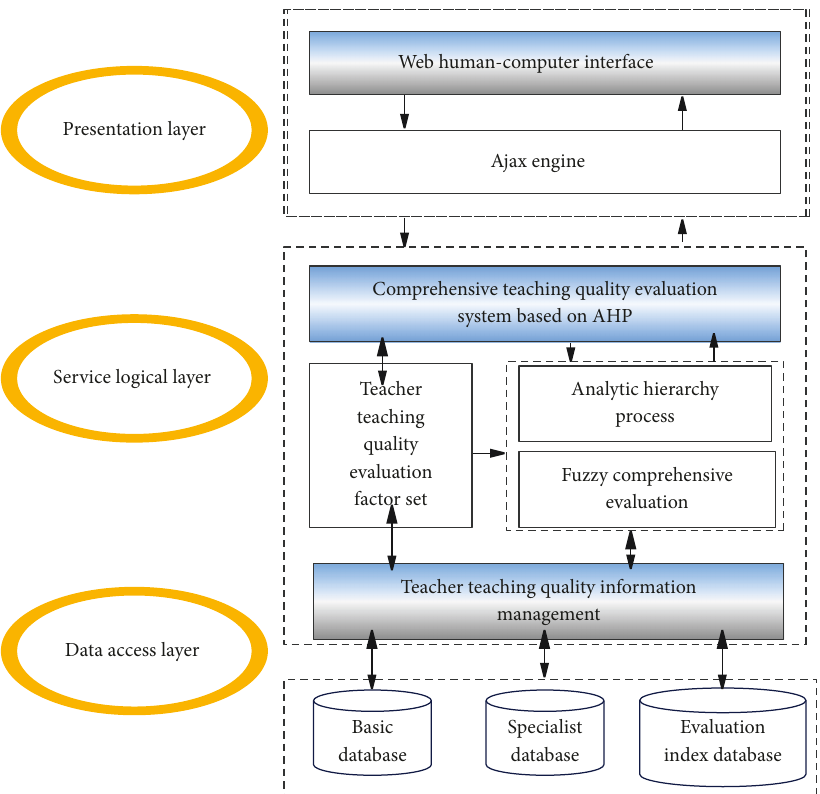
Figure 5: System architecture diagram of the comprehensive evaluation teaching quality evaluation system based on AHP.